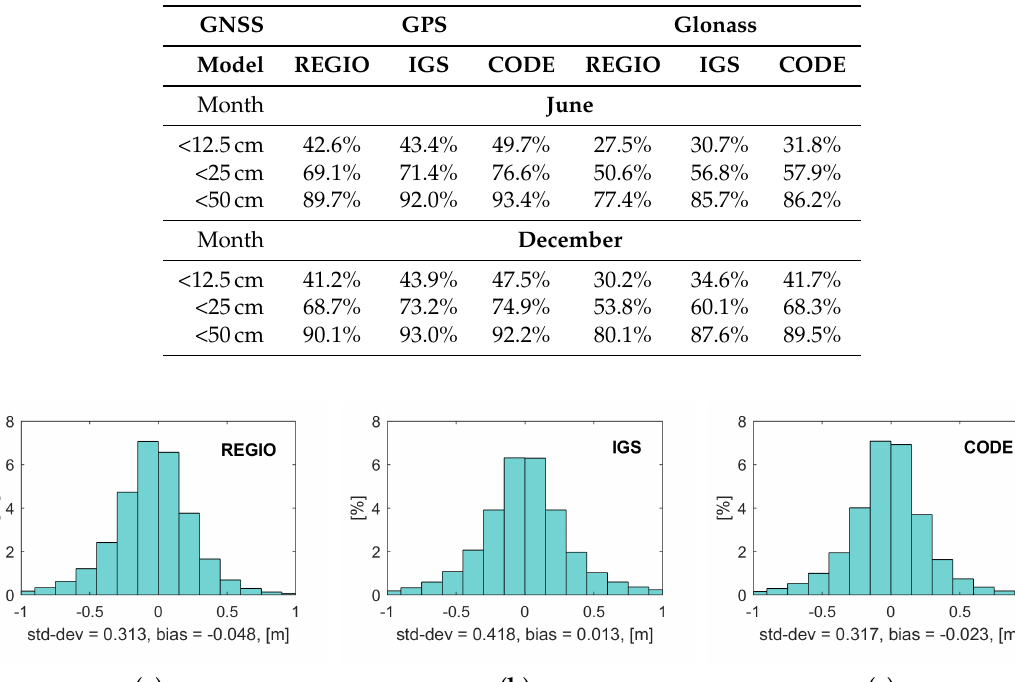
Table 5. Statistics of the difference between the estimated and modeled ionospheric delay for the PPP solution using different ionosphere models as background model for June and December 2019.